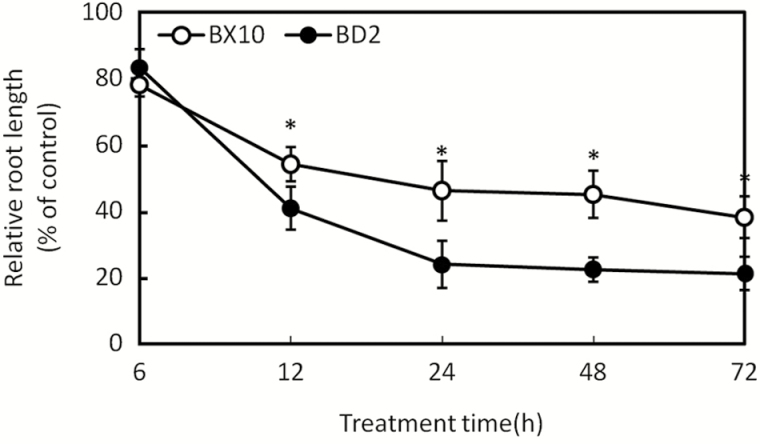
Time course of RRL of BX10 and BD2 soybeans under 0 or 50 μM Al3+ treatments. Error bars denote mean ± SD (n = 15). Asterisk (*) indicates significant difference at P < 0.05.